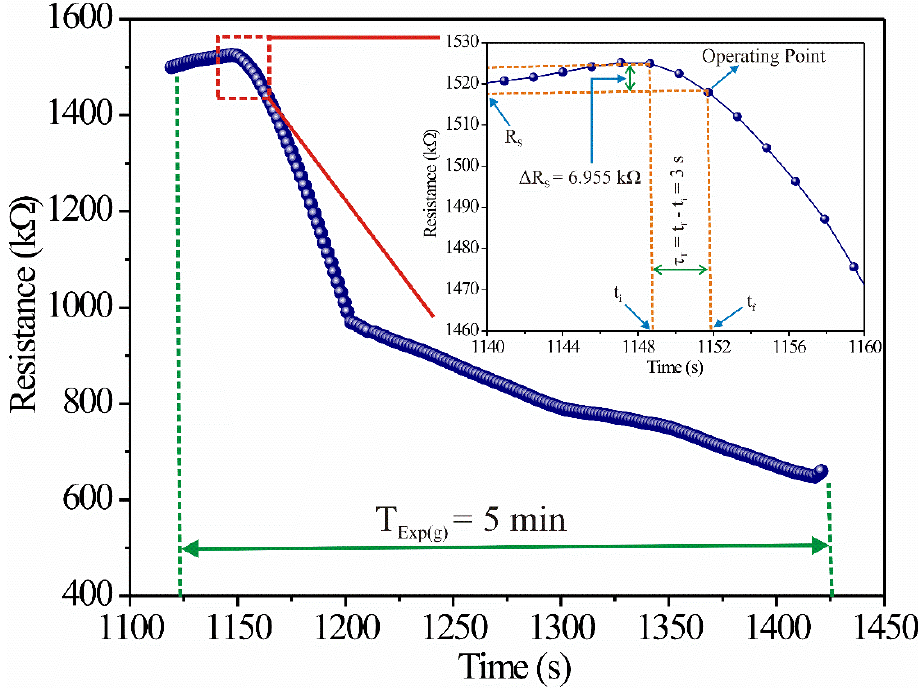
Figure 6. Graphical representation of the operating point and sensor’s response time (3 s).